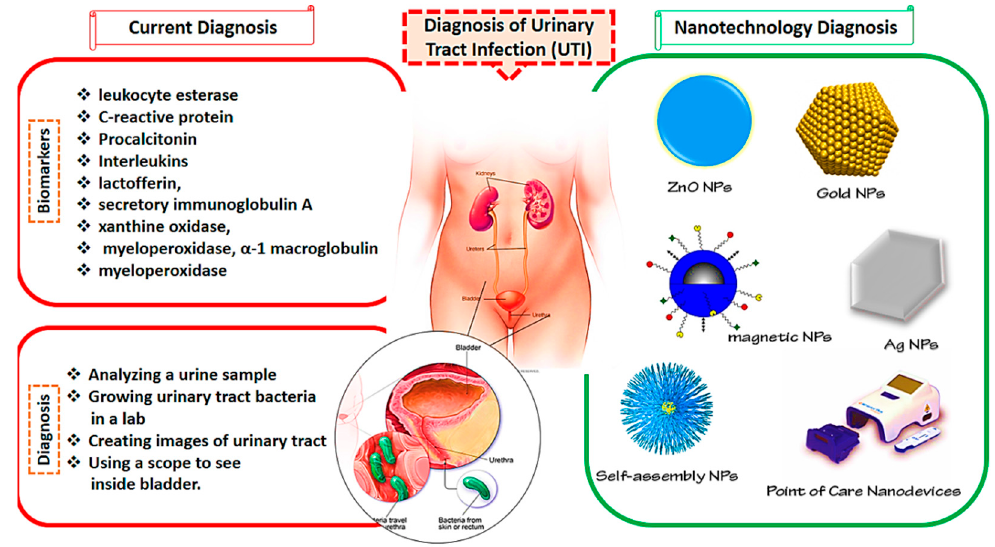
Figure 1. Current methods and nanotechnology approaches for the diagnosis of urinary tract in- fections